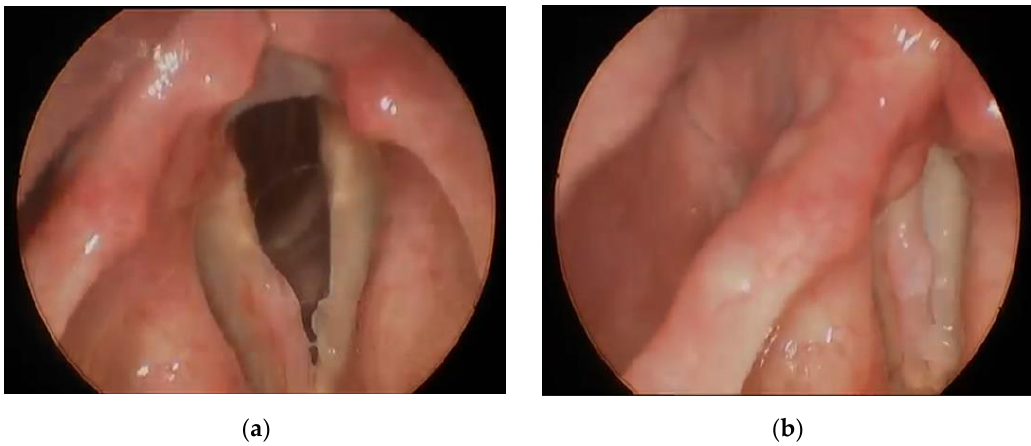
Figure 1. Laryngostroboscopy on presentation shows erythematous right anterior vocal fold thickening: ( a ) open vocal folds; ( b ) closed vocal folds. Figure created by author.